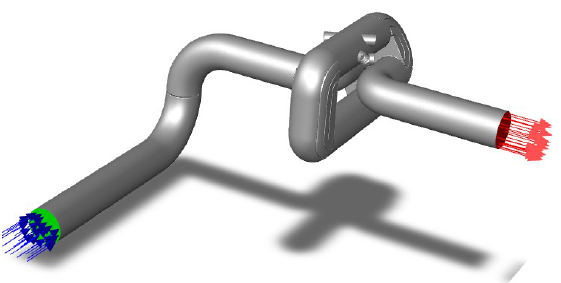
Fig. 4 Case with OIML d+ disturbance – BCs.